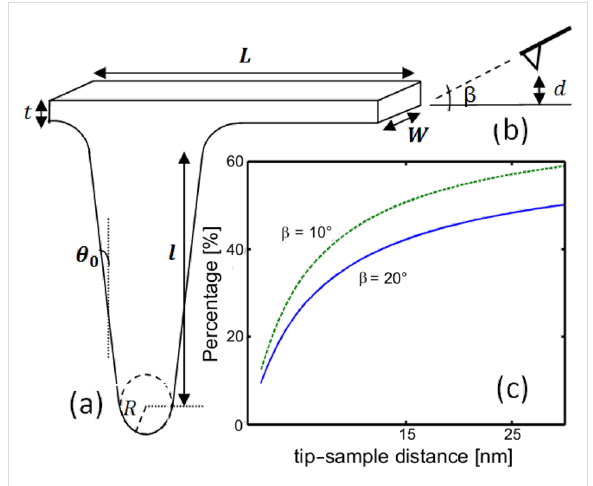
Figure 1: (a) Geometrical model of a tip, with cone length l , half-aper- ture angle θ 0 , spherical apex radius R , and cantilever width, length and thickness W, L and t , respectively. (b) Probe–sample cross section for a probe distance d from the surface, tilted at an angle β . (c) Cantilever homogeneous force contribution relative to the total homogeneous force, as a function of the probe–sample distance for two tilt angles: β = 20° (solid line) and β = 10° (dashed line), with cantilever width of W = 40 μ m. These and all the following results were calculated for the